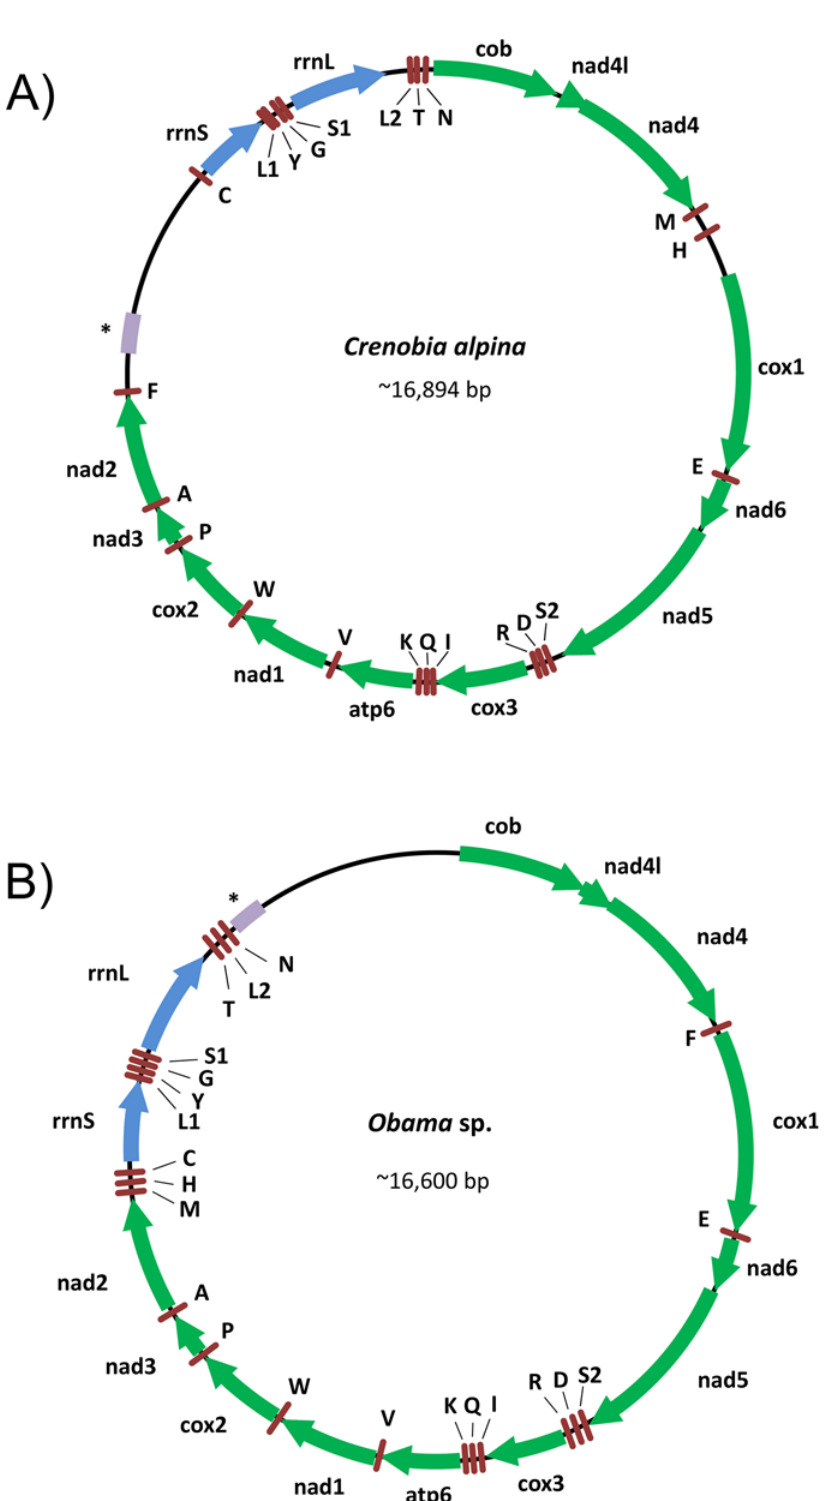
Fig 2. New freshwater flatworm mitogenomes obtained. Arrangement of the mitogenomes of Crenobia alpina (A) and Obama sp. (B). Green arrows correspond to the protein coding genes; blue arrows ribosomal genes; brown rods tRNAs; Purple bar indicates the putative repetitive region; * indicates that the relative length of the region may be different. Gene identifier: rrnS / rrnL = small and large subunit rRNA,